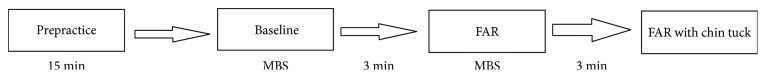
The series of steps involved in the recording procedure.